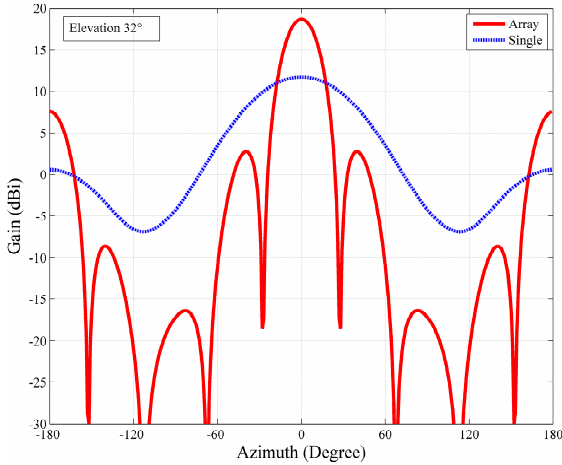
Figure 6. Comparison of the radiation patterns between a single antenna (blue line) and the antenna array (red line) at 10 MHz (main lobe vector alignment), where dBi values are with reference to an isotropic gain pattern.